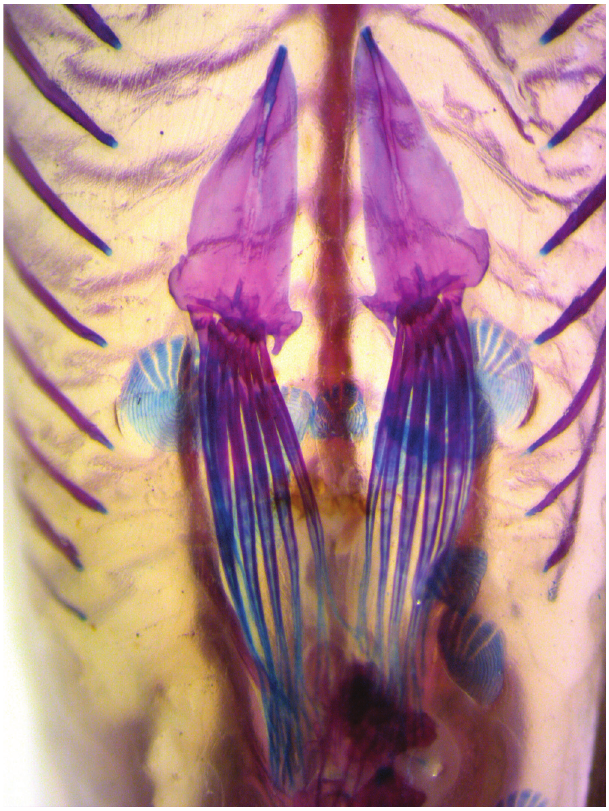
Fig. 2. Pelvic girdle of Jenynsia luxata , paratype, male, CI-FML 5465, 27.8 mm SL.